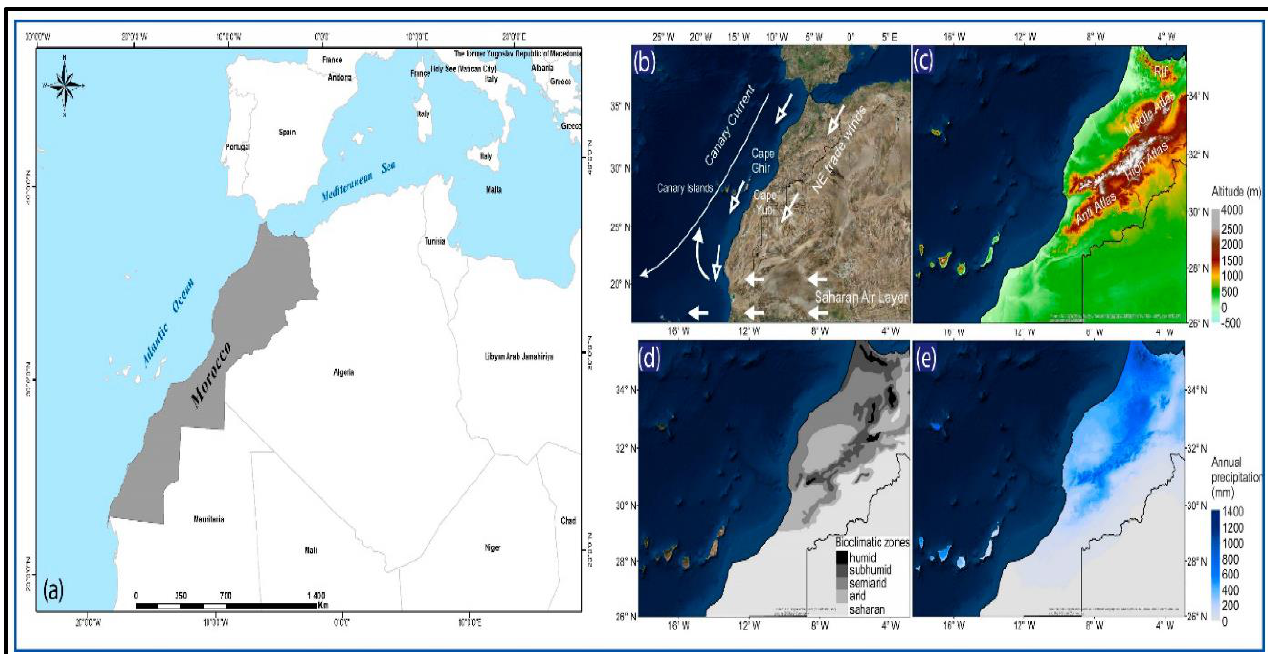
Figure 1. ( a ) Geographical location of Morocco; ( b ) major atmospheric systems and the Canary Current; ( c ) the regional topography; ( d ) distribution of bioclimatic zones; ( e ) distribution of annual precipitation [21]. Table 1. Types of bottled water